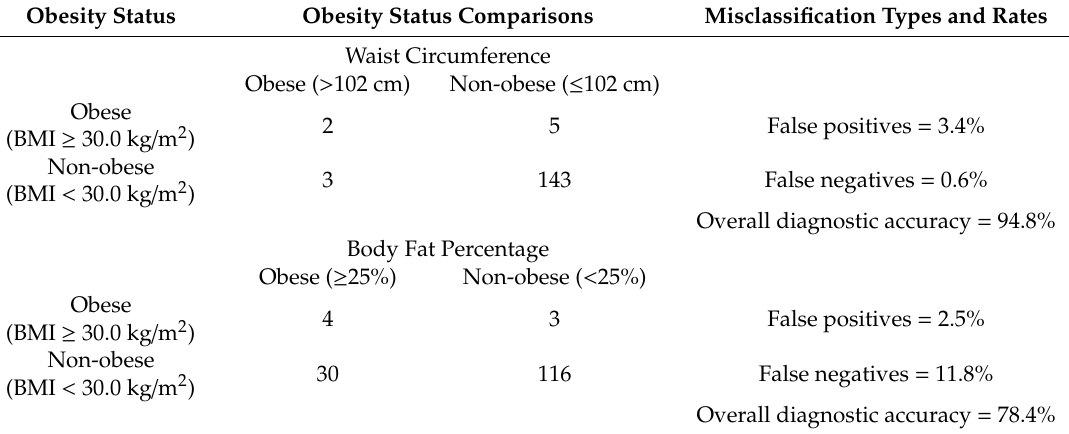
Table 1. Rates of false positives and false negatives using BMI-defined obesity classification in comparison to waist circumference (WC)-defined and body fat percentage (BF%)-defined obesity for men ( n = 153).